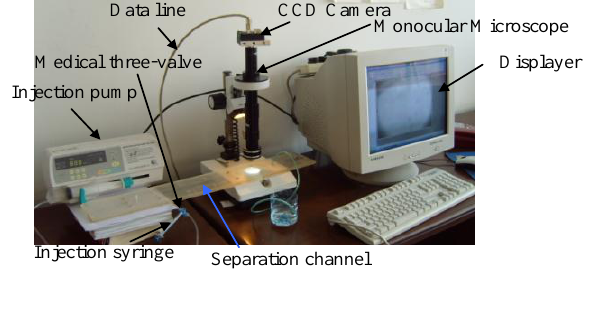
Figure 6. Experimental setup of the gravitational field flow fractionation